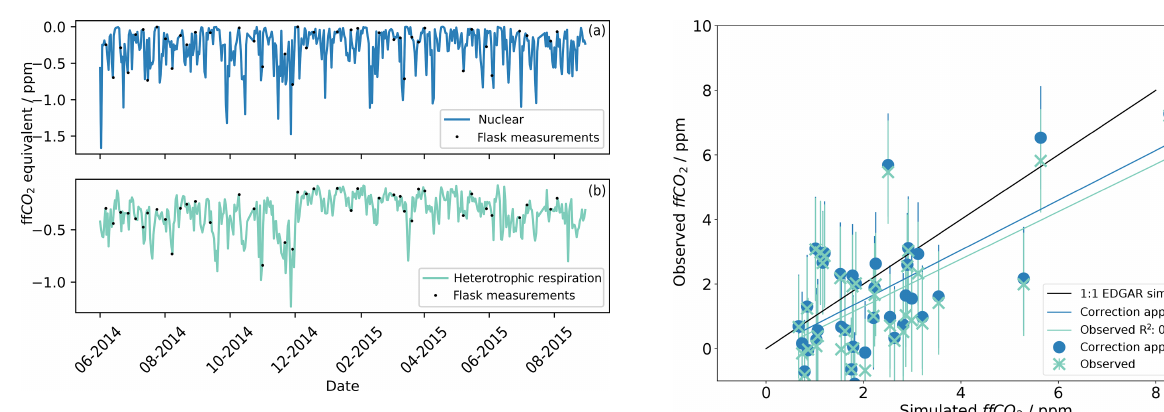
Figure 3. The blue line (a) represents the ffCO 2 equivalent theoret- ical corrections that need to be applied over the whole study period for the nuclear 14 CO 2 emissions (see Sect. 3.3.2). The green line (b) represents the ffCO 2 equivalent theoretical corrections that need to be applied over the whole study period for heterotrophic respira- tion from the biosphere (see Sect. 3.3.1). The black points represent times that flask samples were taken and therefore the corrections that were applied to each flask measurement.